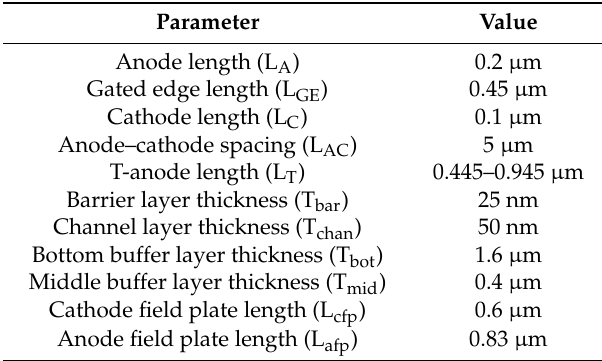
Table 1. Major optimized parameters of the proposed